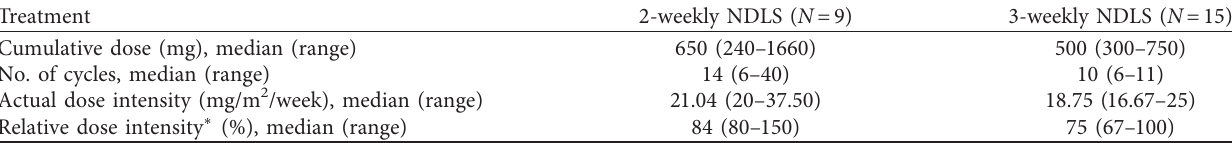
Table 2: Treatment delivery.